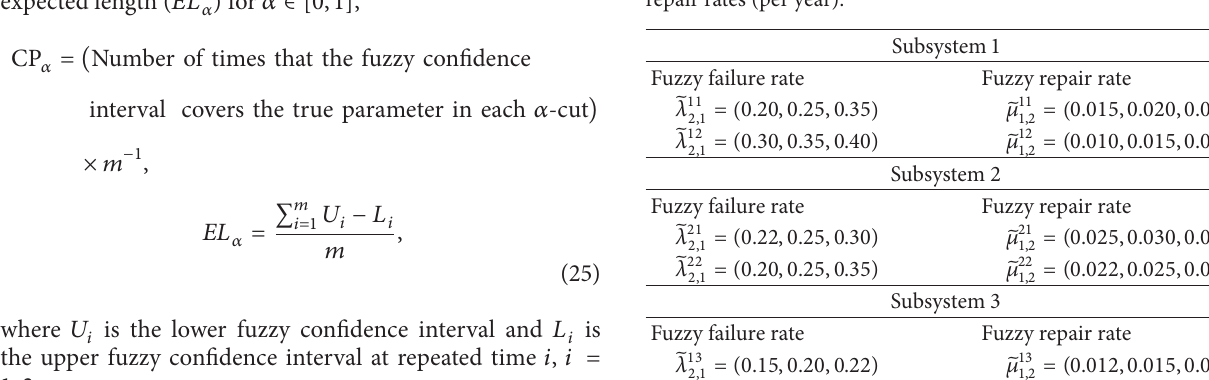
Table 1: Triangular fuzzy number of fuzzy failure rates and fuzzy repair rates (per